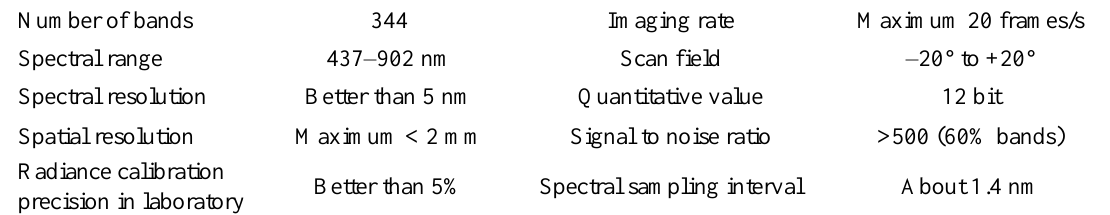
Table 1. Main parameters and performance of